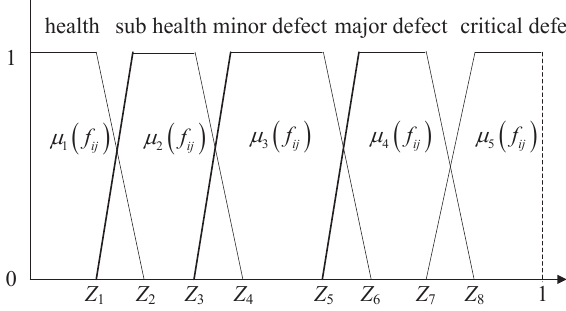
Figure 2. Membership function for the condition evaluation of